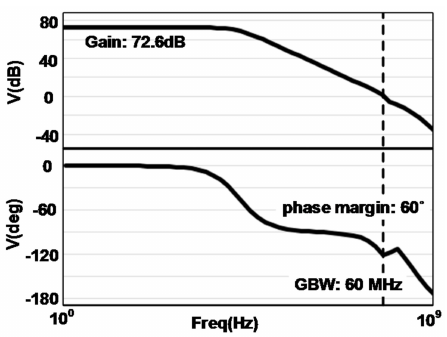
Figure 14. Pre–amplifier gain, phase margin and gain bandwidth.